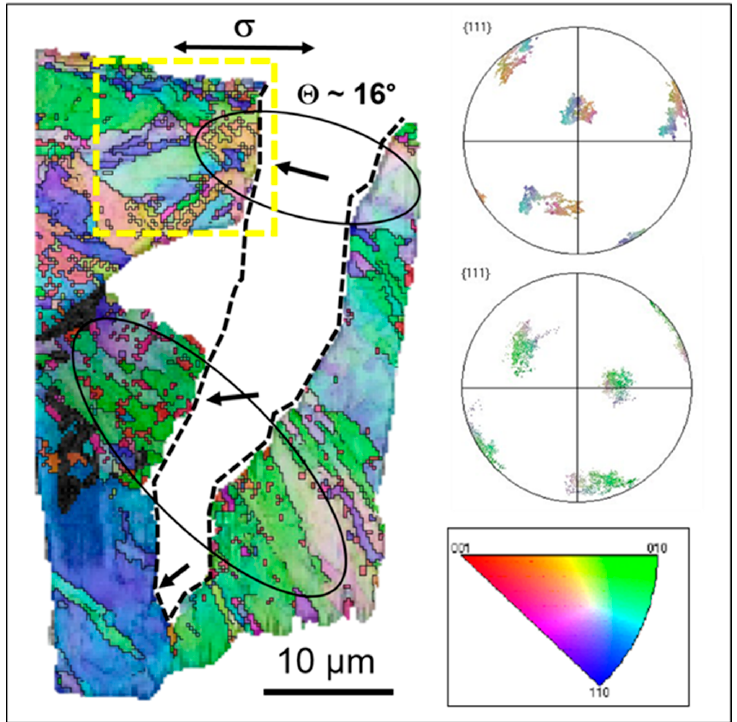
Figure 5. EBSD orientation map (transverse direction (TD) inverse pole figure color coding) exhibiting mainly LME-induced transgranular and translath crack propagation and intergranular cracking towards the tip (marked with black arrows). Pole figures show the orientation of two different families of martensitic laths. The yellow dashed region was investigated further in more detail (see Figure